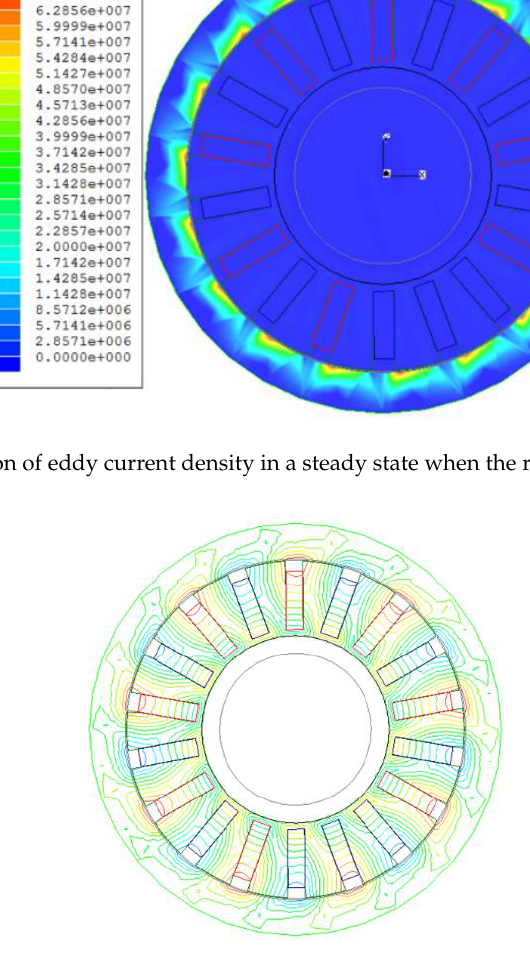
Figure 7. Distribution of magnetic flux in a steady state when the rotating speed is 1500 rpm.